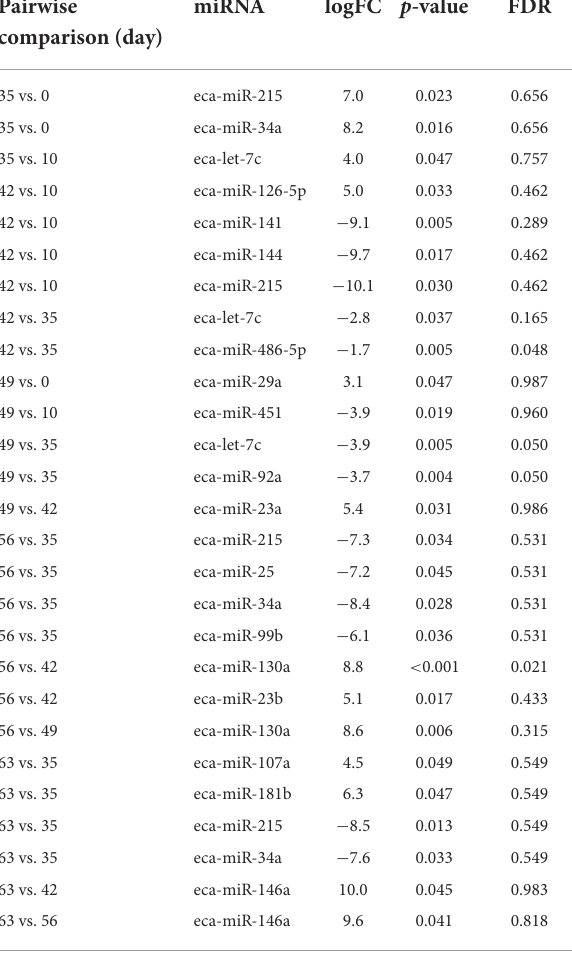
TABLE 2A Differentially expressed miRNAs following pairwise analysis in plasma-derived EVs.